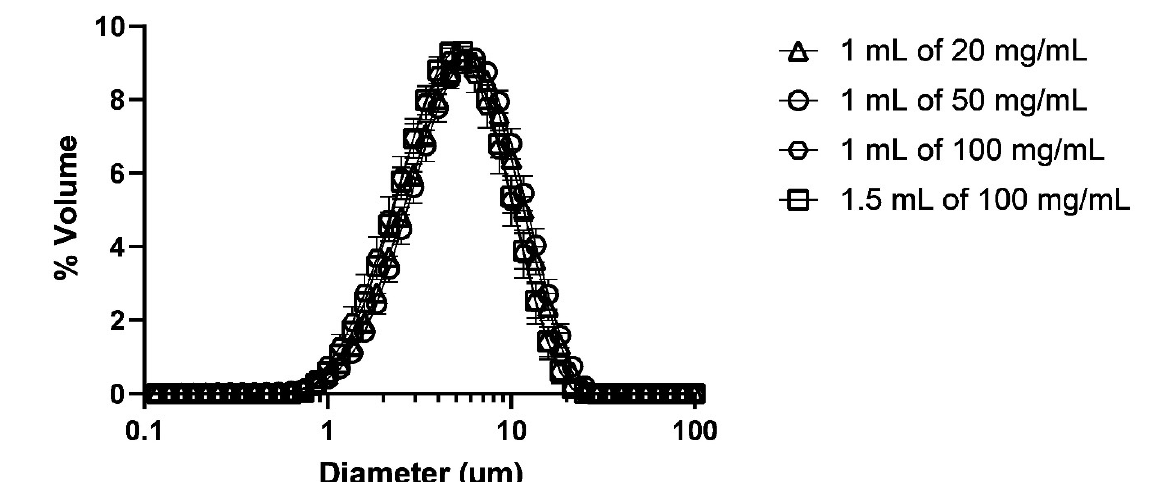
Figure 3. Droplet size distributions measured by laser diffraction. Data presented as mean ± standard deviation ( n = 9).